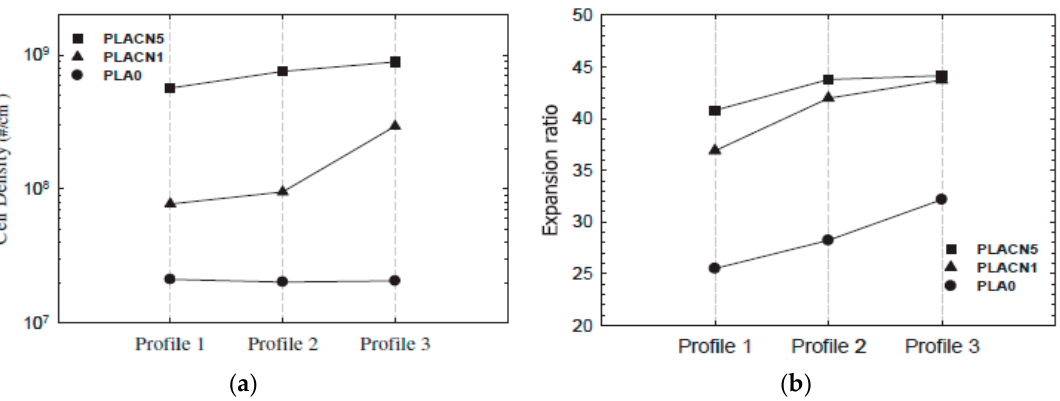
Figure 31. ( a ) Cell density and ( b ) expansion ratio of foams obtained by varying temperature profiles in the second extruder of tandem line foaming extrusion system from neat PLA (PLA0) and PLA with 1 wt% (PLACN1) and 5 wt% (PLACN5) of Cloisite 30. Reprinted from Keshtkar et al. [151]. Copyright (2020), with permission from Elsevier.